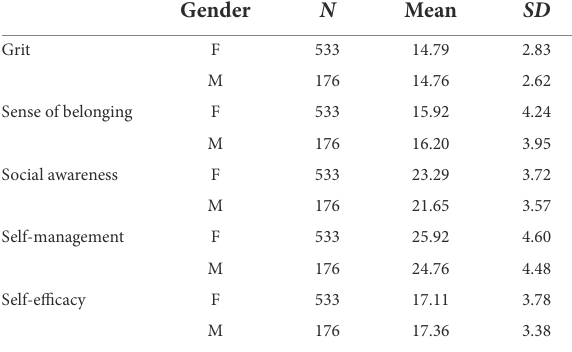
TABLE 4 Difference between